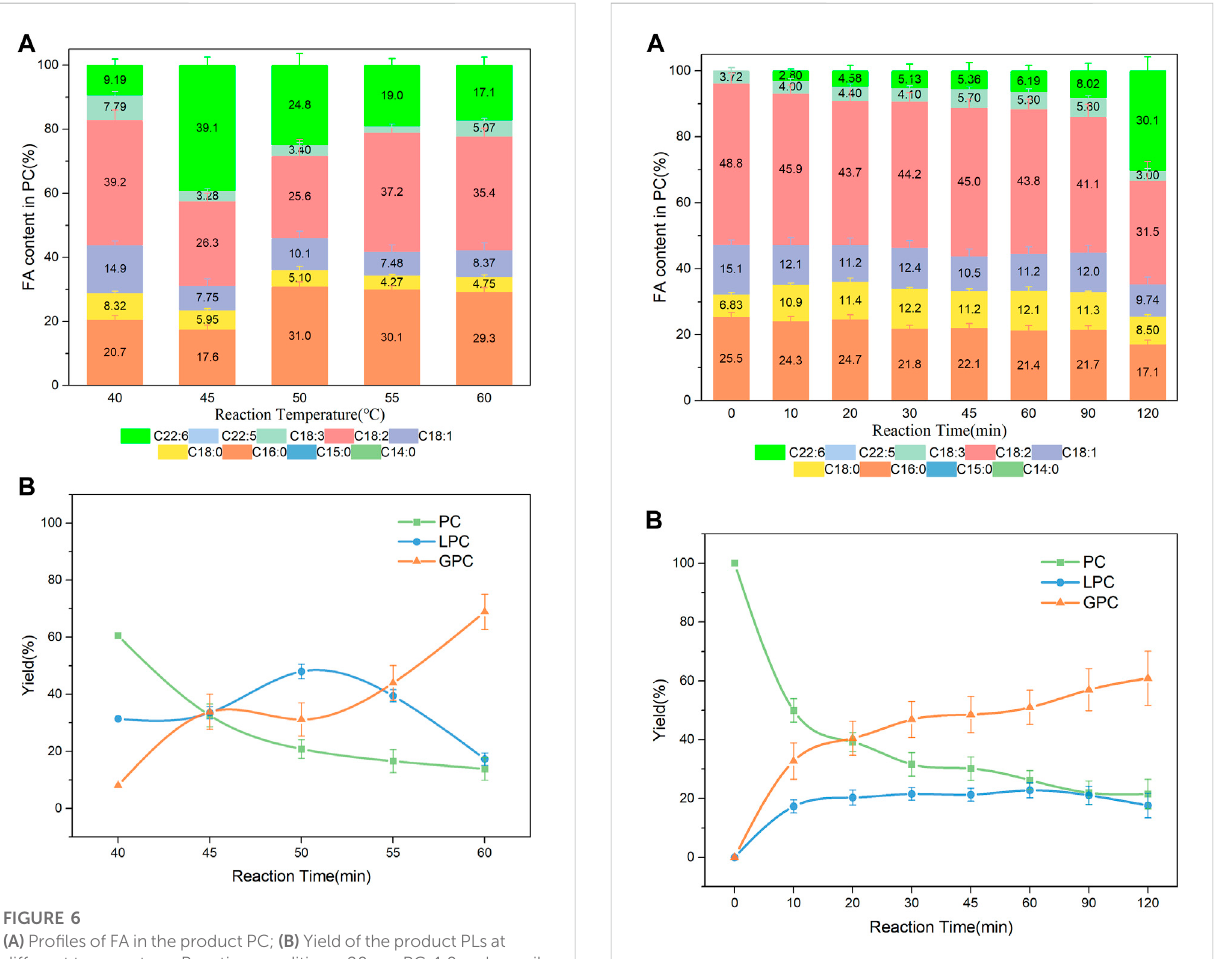
FIGURE 7 (A) Pro fi lesofFAintheproductPC; (B) YieldoftheproductPLs in PLA1-mediated transesteri fi cation of PC with DHA-ME; Reaction conditions: 20 mg PC, 1.0 g DHA-ME derivatized from algae oil, 10 µL PLA1, 45 ° C, 500